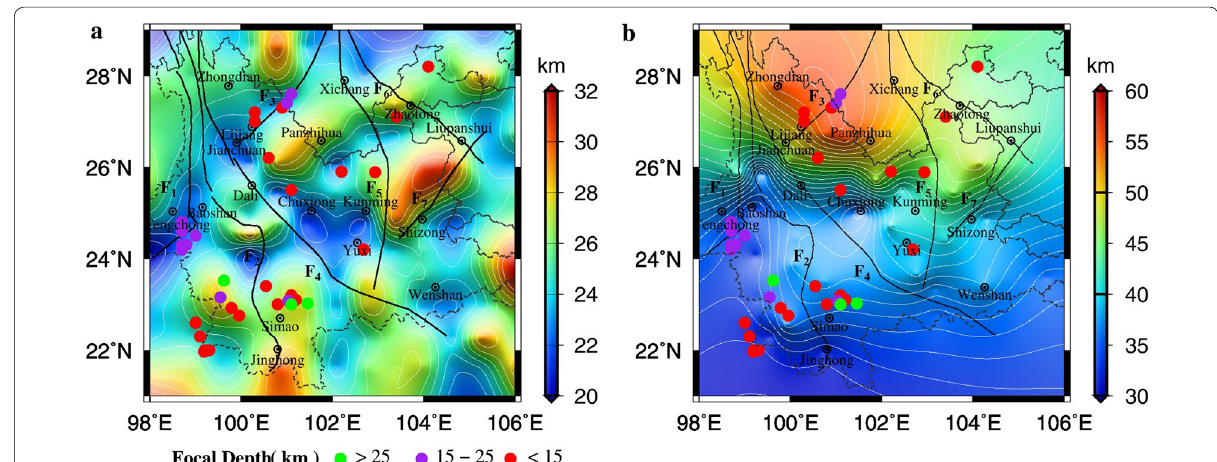
Fig. 7 Depth of the Curie surface ( a ) and Moho surface ( b ) in the research area, as well as the focal depths of the earthquakes with M s study region ( b is modified from Deng et al.